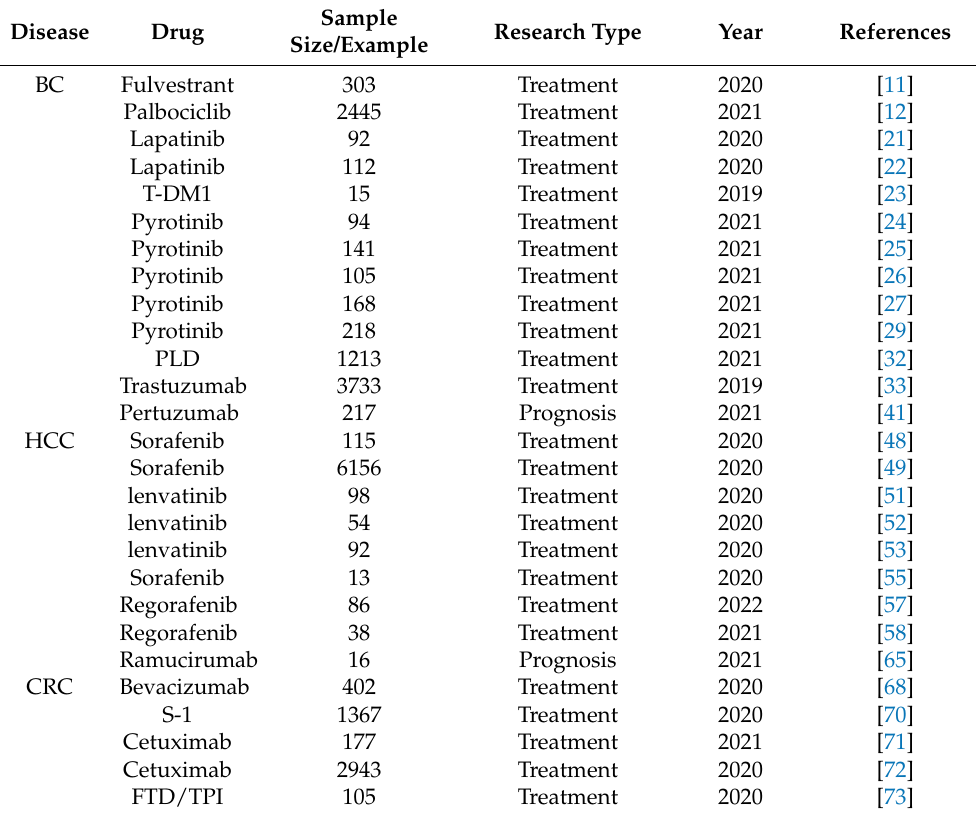
Table 2. RWS for drug treatment of malignant tumors.